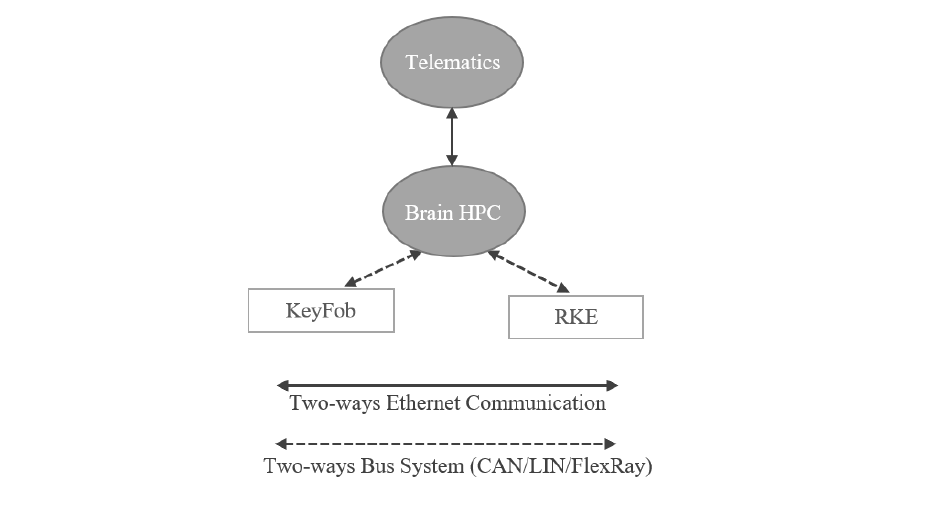
Figure 11. Use Case Representation of One-Brain Architecture.